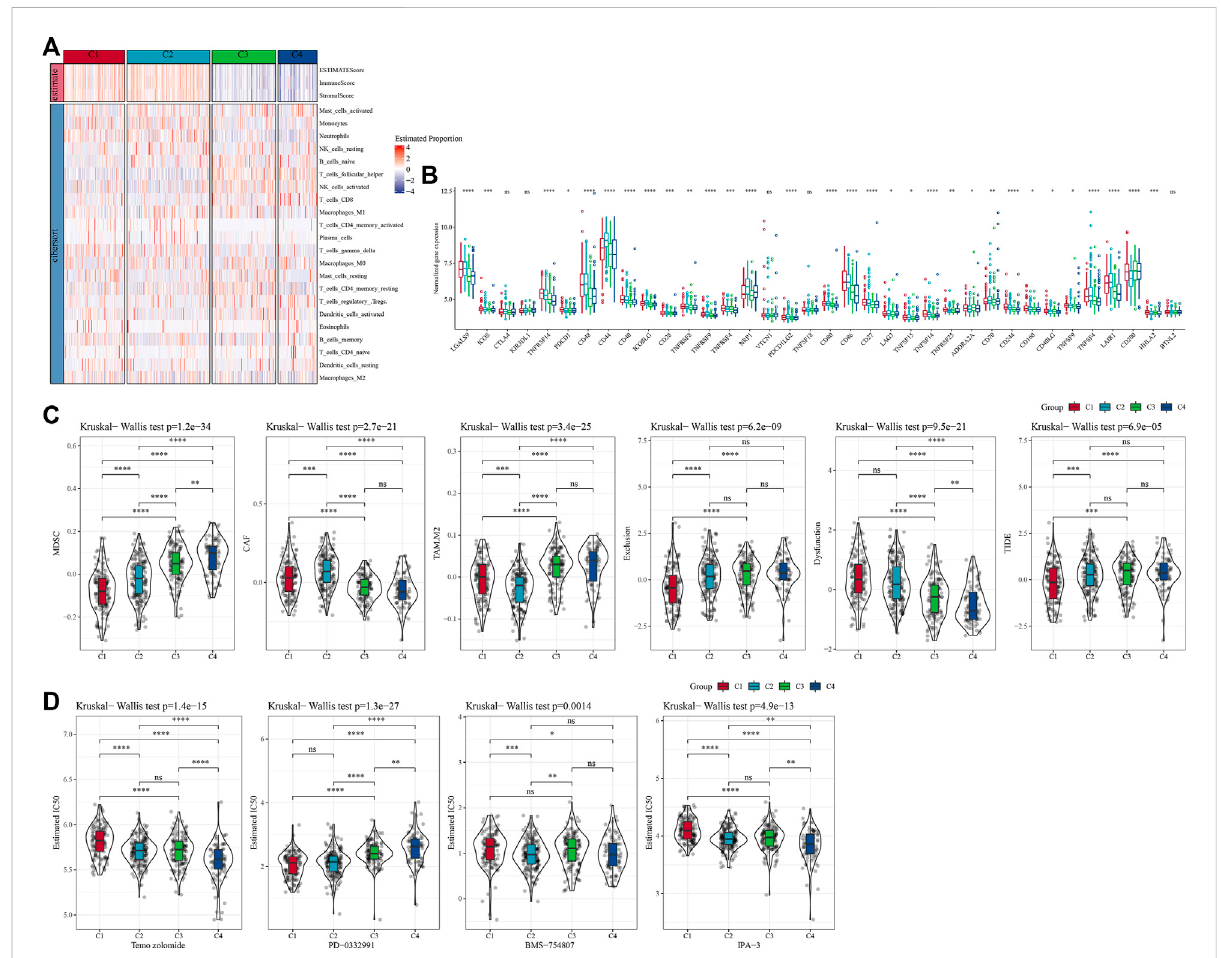
FIGURE 4 Differencesofimmunecell in fi ltration in differentmolecularsubtypes. (A) The differences of22 immunecell scores amongdifferent molecular subtypesintheTCGA-GBMcohort;ThedifferencesofESTIMATEimmunein fi ltrationamongdifferentmolecularsubtypesintheTCGA-GBMcohort; (B) Immunocheckpoints for differential expression between different subgroups in the TCGA-GBM cohort; (C) Difference in TIDE analysis results between groups intheTCGA-GBM cohort; (D) The box plots oftheestimatedIC50 for temozolomide,PD-0332991,BMS-754807 andIPA-3in TCGA-GBM